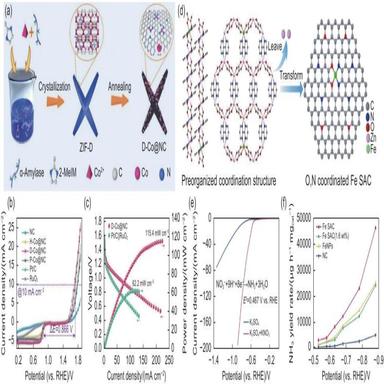
a) Schematic of the formation of Co nanoparticle grafted on N-doped carbon. (b) The corresponding linear sweep voltammetry curves for both ORR and OER at 1 600 r min−1 . (c) Discharge curve and corresponding power density. Reproduced with permission. Copyright @ 2022 Elsevier Ltd. (d) Schematic of the formation of Fe single-atom catalysts. (e) The corresponding linear sweep voltammetry and (f) NH3 yield . Reproduced with permission. Copyright @ 2022 Elsevier Ltd.